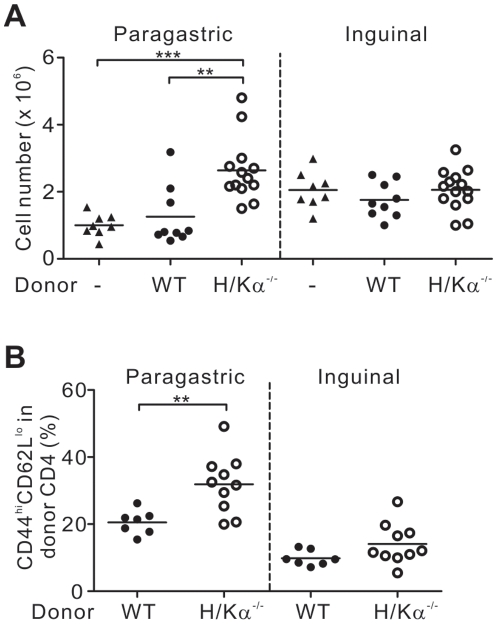
Cellularity of stomach-draining and non-draining lymph nodes.(A) The number of cells in the paragastric and inguinal lymph nodes from recipient mice 8 weeks after transfer of either wildtype or H/Kα−/− CD4+ T cells. (B) The percentage of effector/memory T cells in the donor population with the phenotype CD44hiCD62Llo in CD90.2+ CD4+ T cells. Data pooled from four independent experiments. Each circle represents the data from one mouse. Mann-Whitney U test was used; bars, mean, **, P<0.01 and ***, P<0.001.